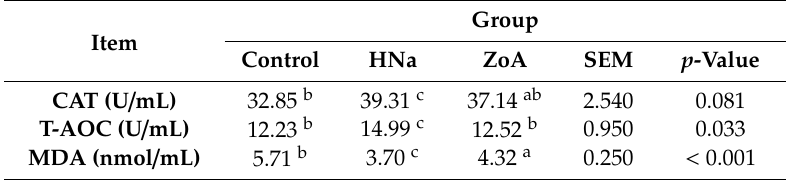
Table 4. E ff ects of HNa on serum antioxidant function in